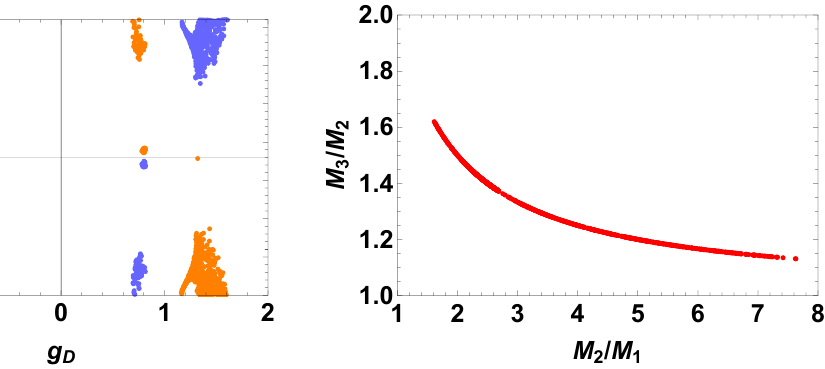
Figure 10 . The allowed curve of ratios of right-handed Majorana masses in the M 2 /M 1 – M 3 /M 2 plane.